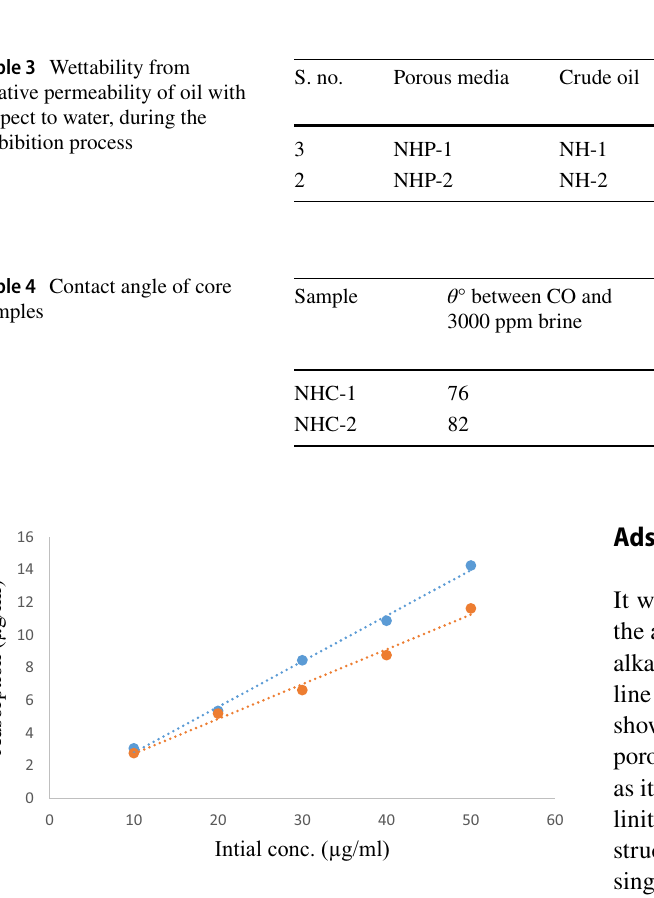
Fig. 11 Adsorption of surfactant in the presence and absence of